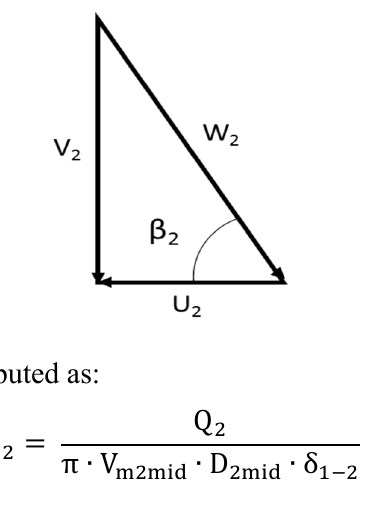
Figure 11. General outlet velocity